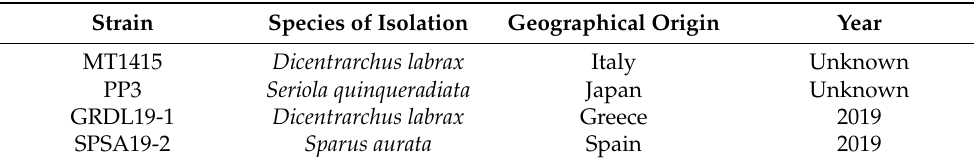
Table 2. Phdp strains used in this study.